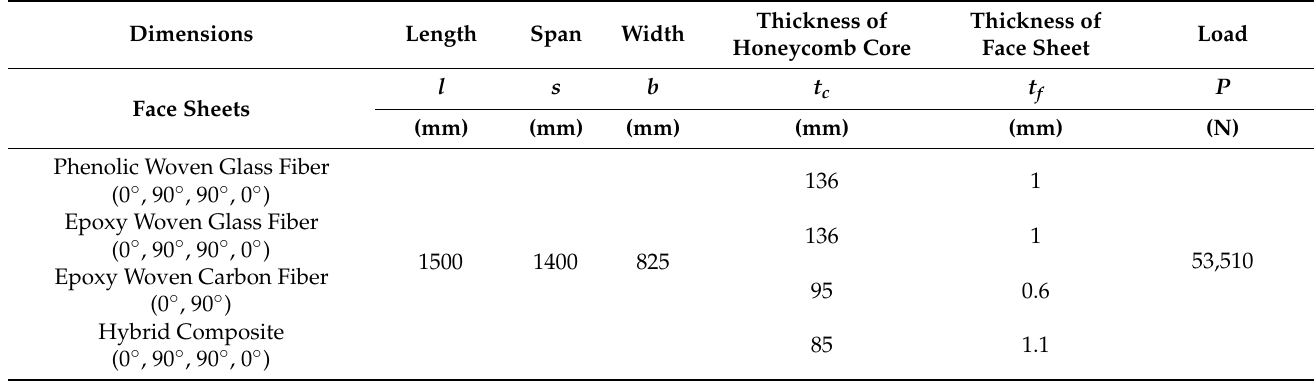
Table 9. Dimensions of honeycomb sandwich models of helicopter floor.